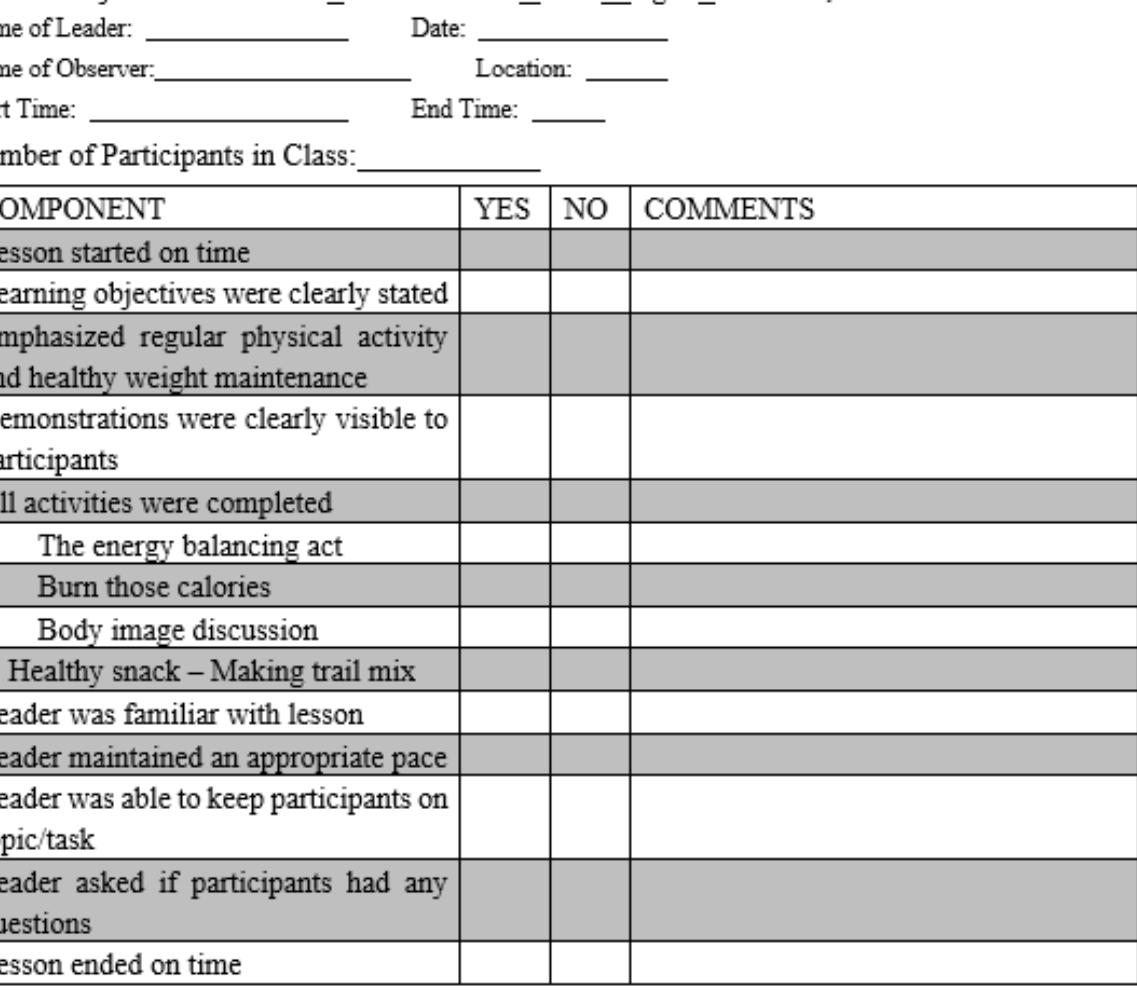
Figure 1. Fidelity log for lesson 1.